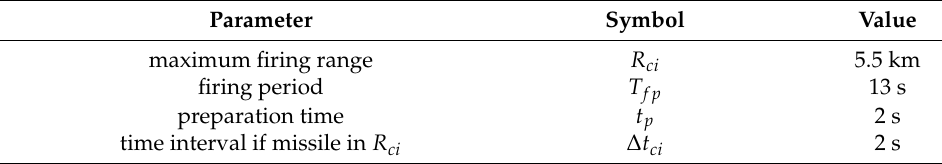
Table 7. Parameters of CIWS.